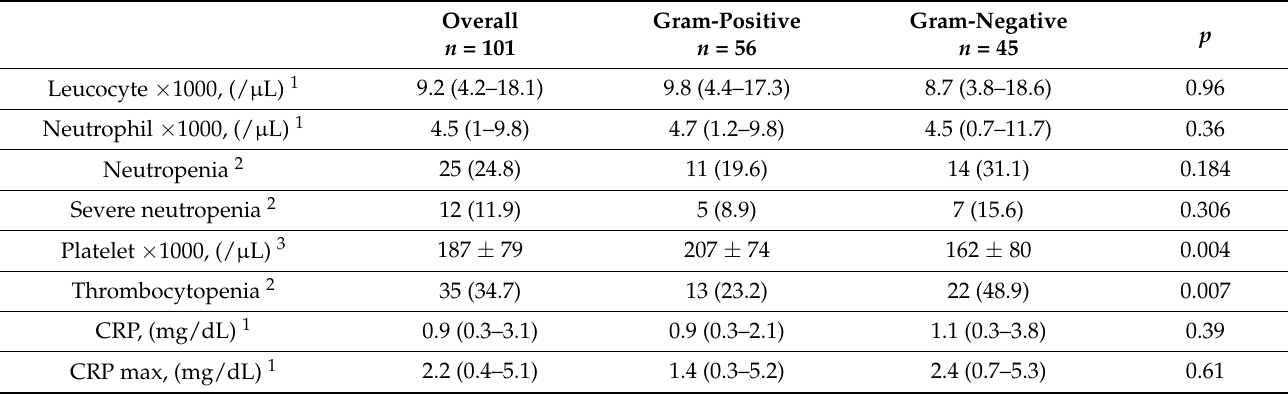
Table 3. Laboratory values of patients at the time of EOS.